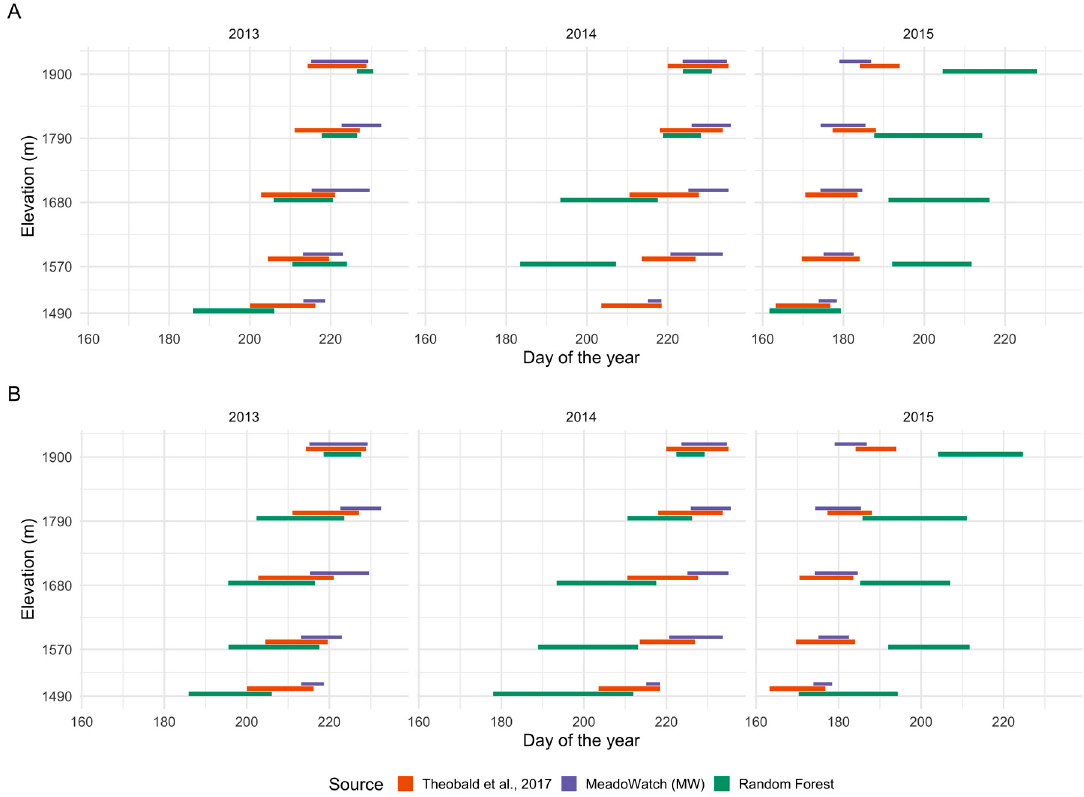
Figure 7. Qualitative comparison of observed window from the in-situ observations of (Theobald et al., 2017), MeadoWatch program, and Random Forest (RF) based flowering window. ( A ) Predicted and Observed peak flowering window when only 3-m (PS) resolution data was used for training. ( B ) Predicted and Observed peak flowering window when 3-m (PS) resolution, along with 10-m (S2-1B) and 30-m (L8) data, was used for training.